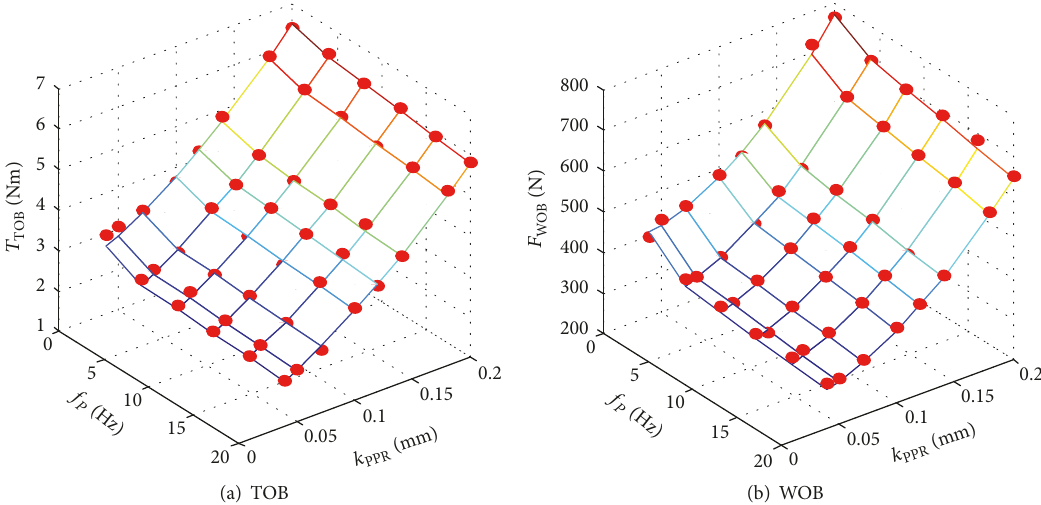
Figure 13: Trends of the rotary-percussive drilling load of the LRCB as functions of the percussion frequency and PPR.